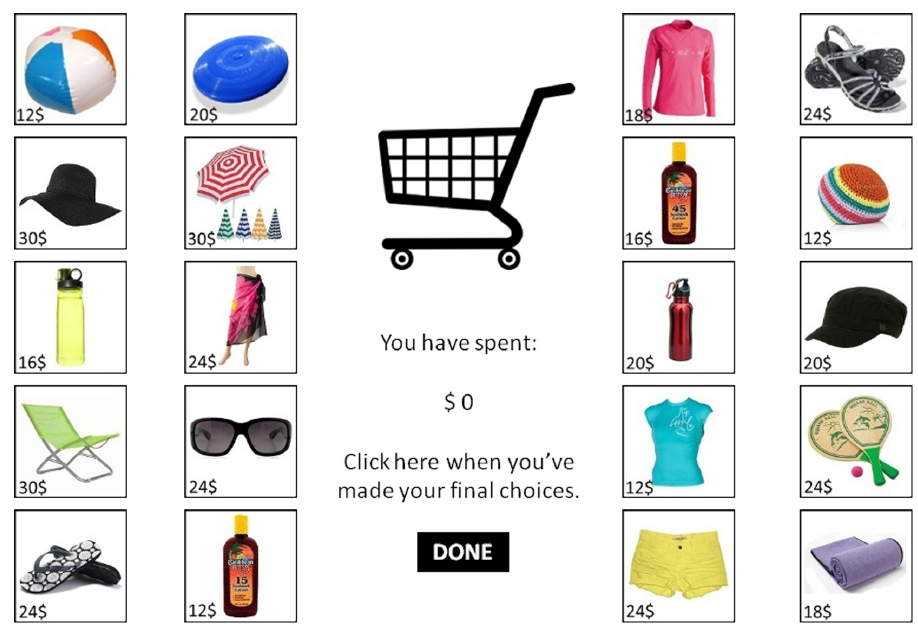
Figure 1. Lost luggage game.